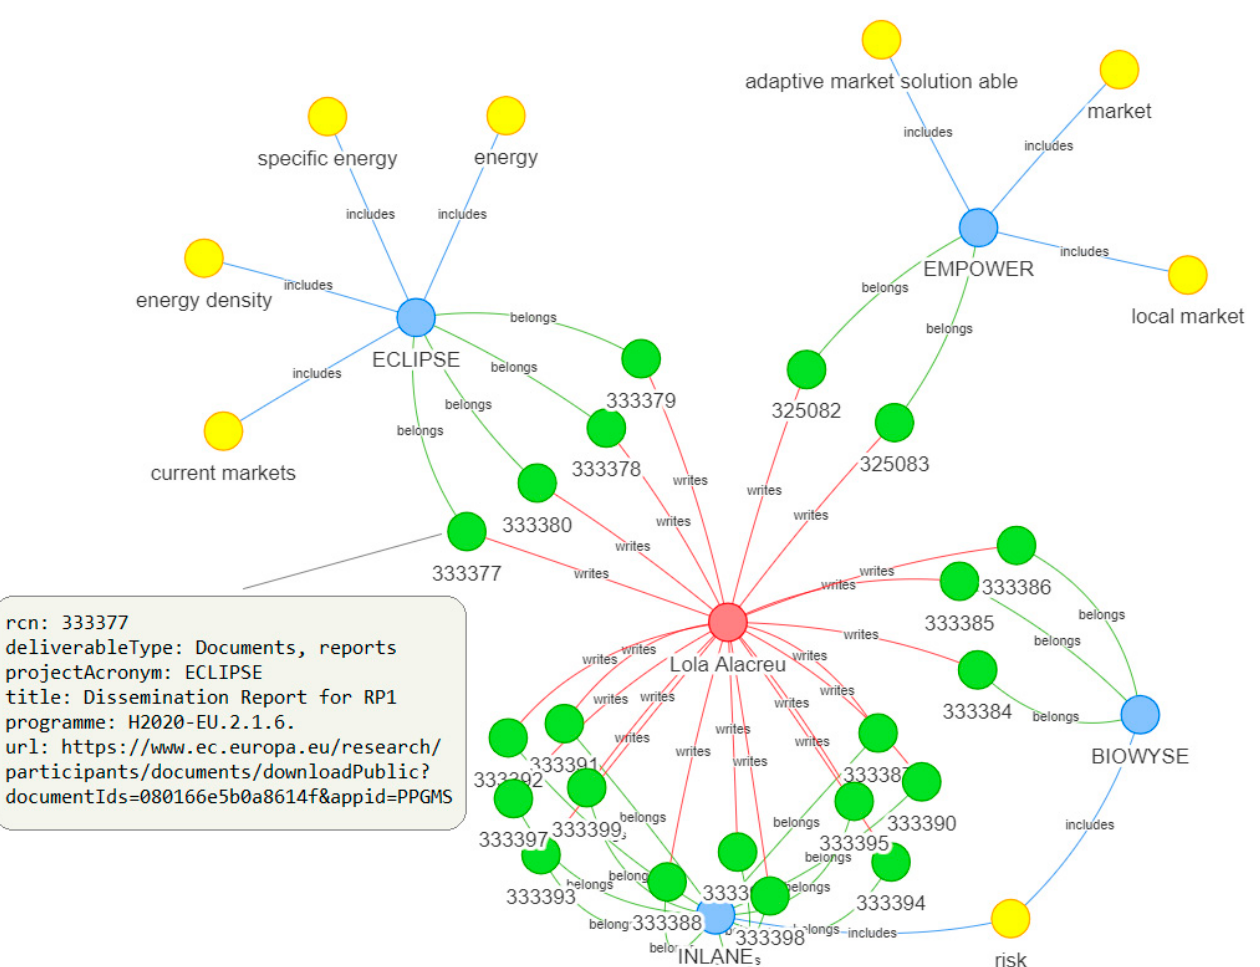
Figure 5. Visualization of a specific organization and some of its projects and respective deliverables.